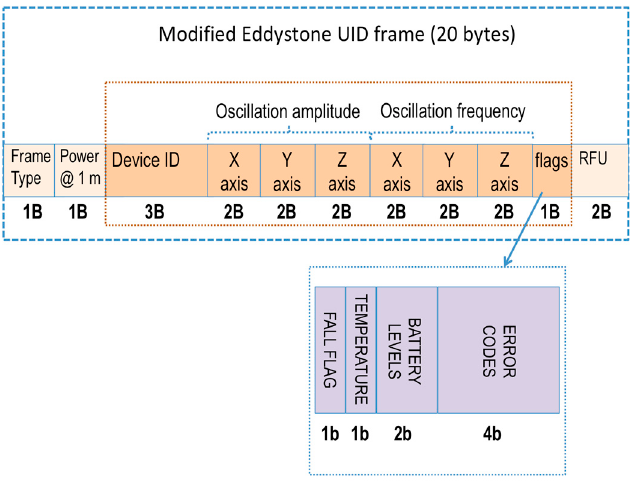
Figure 12. Modified Eddystone UID advertising frame.